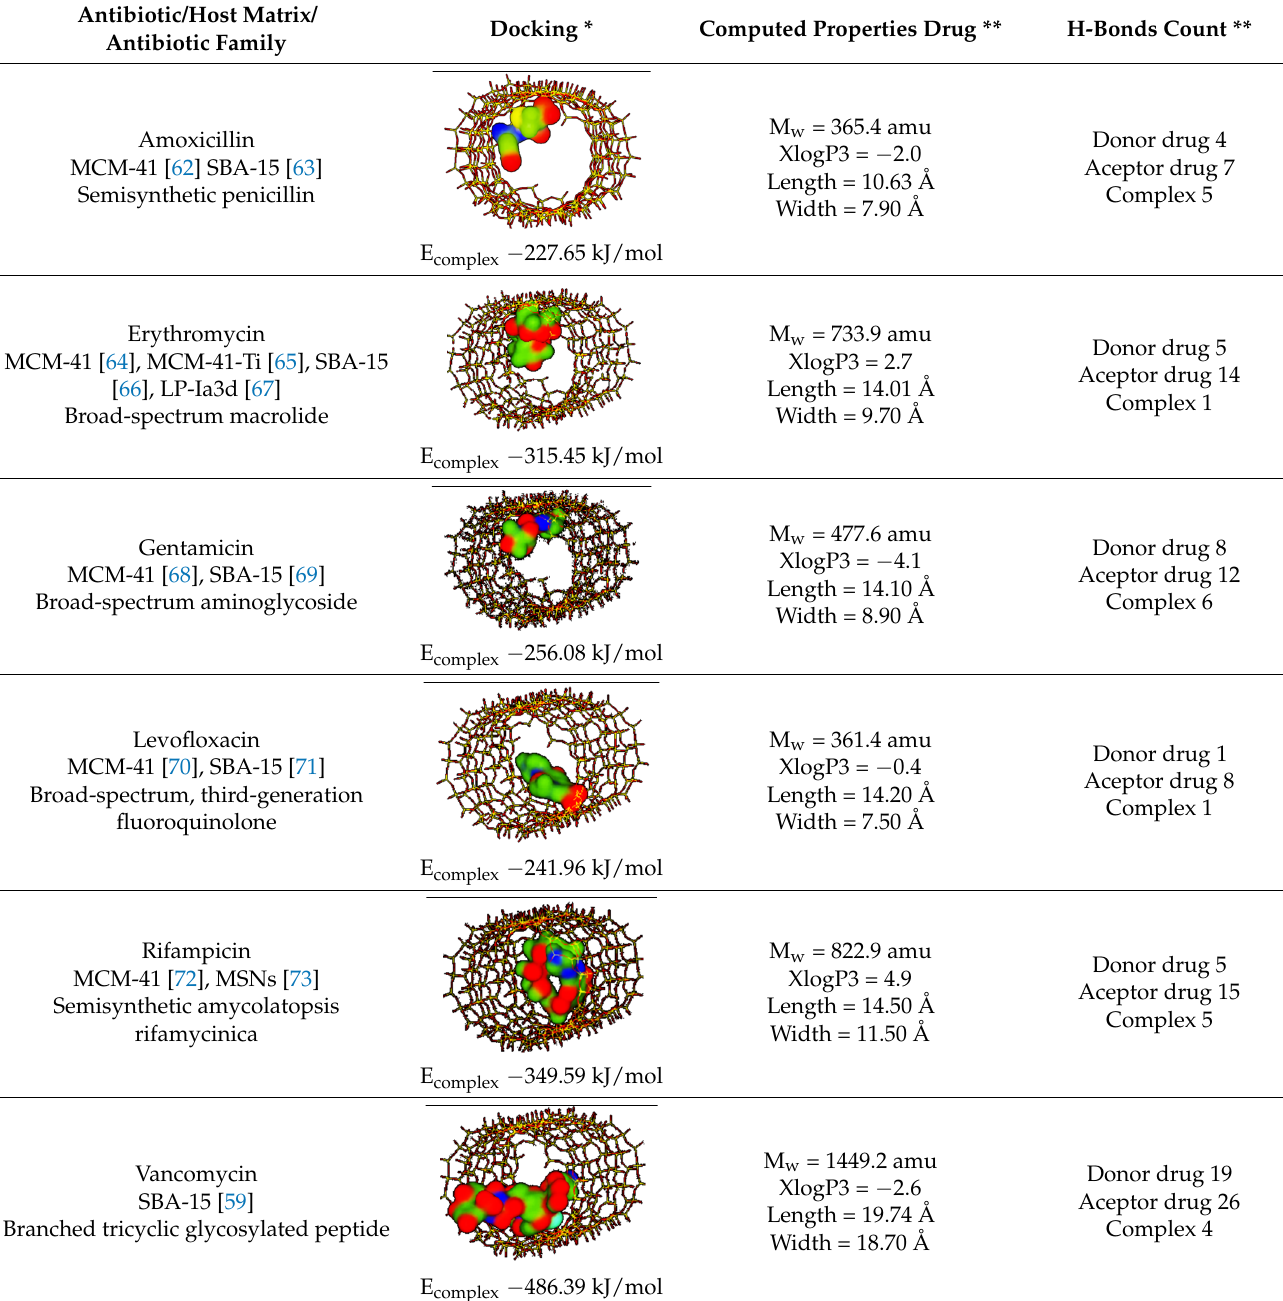
Table 1. Summary of selected representative antibiotics that have been hosted into different pure-silica mesoporous matrices for controlled delivery proposes. Results derived from molecular modelling and docking studies of MCM-41-antibiotic host–guest interactions, carried out using Hex 8.0 software, are also shown (unpublished data).